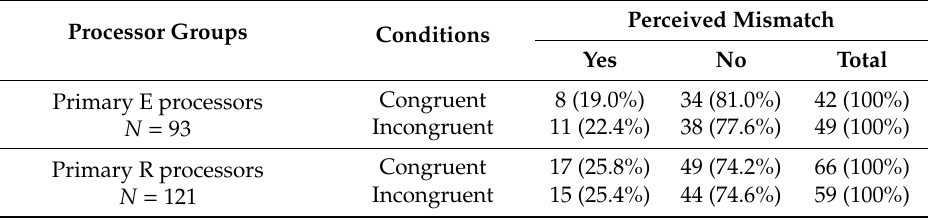
Table 10. Count and proportion (%) of perceived mismatch amongst (in)congruent conditions for primary E processors and primary R